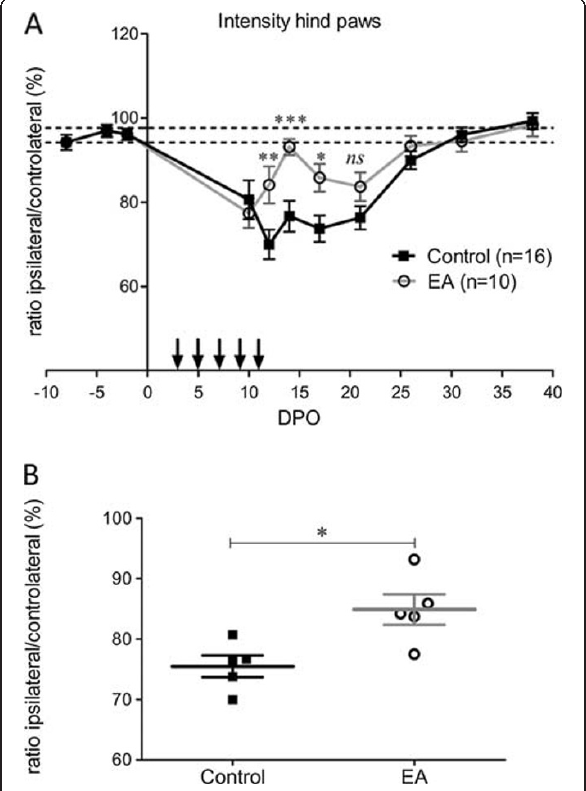
Figure 3 Analysis of walking runs recovery. ( A ) Time course of the number of normal runs after left sciatic nerve crush in control and electro-acupuncture (EA) groups. Each mouse was tested for three runs. Graph shows the total percentage of runs tested with 16 control mice and 10 electro-acupuncture-treated mice at 10, 12, 14, 17, 21, 26, 31 and 38 DPO (group 1). Vertical arrows indicate electro- acupuncture application. ( B ) Bar graph representation of the number of normal runs between 10 and 21 DPO. * p<0.05 ( X 2 test).